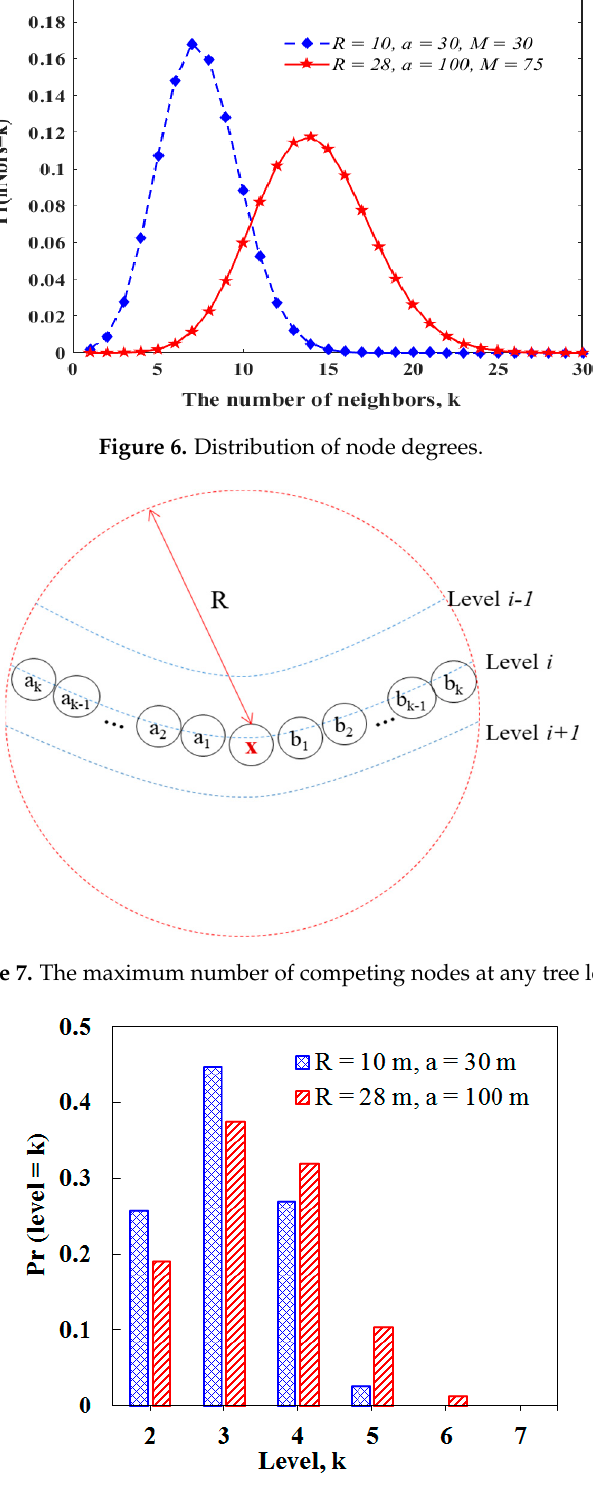
Figure 8. Probability distribution of tree levels.